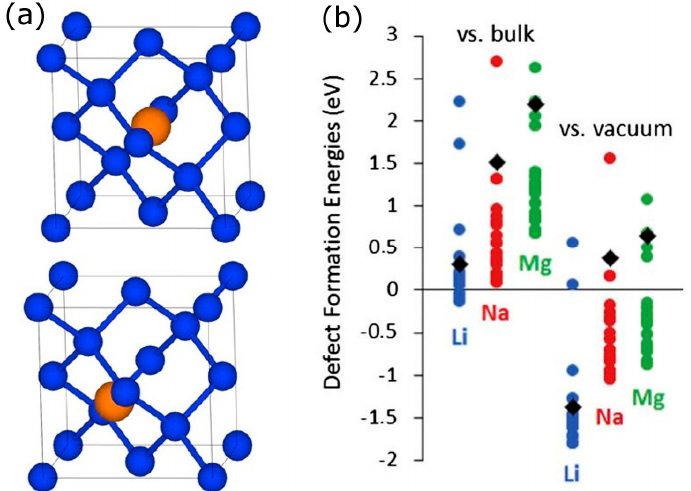
Figure 1. ( a ) Tetrahedral ( top ) and hexahedral ( bottom ) sites in the diamond crystal structure of Si; ( b ) Computed defect formation energies of Li, Na, and Mg in Si vs. vacuum and bulk metal reference states. Values for c -Si are shown as black diamonds and values for multiple insertion sites in a -Si as colored circles. Reprinted with permission from Ref. [13], © (2013) Elsevier ( a ) and from Ref. [20], © (2014) Elsevier ( b ).